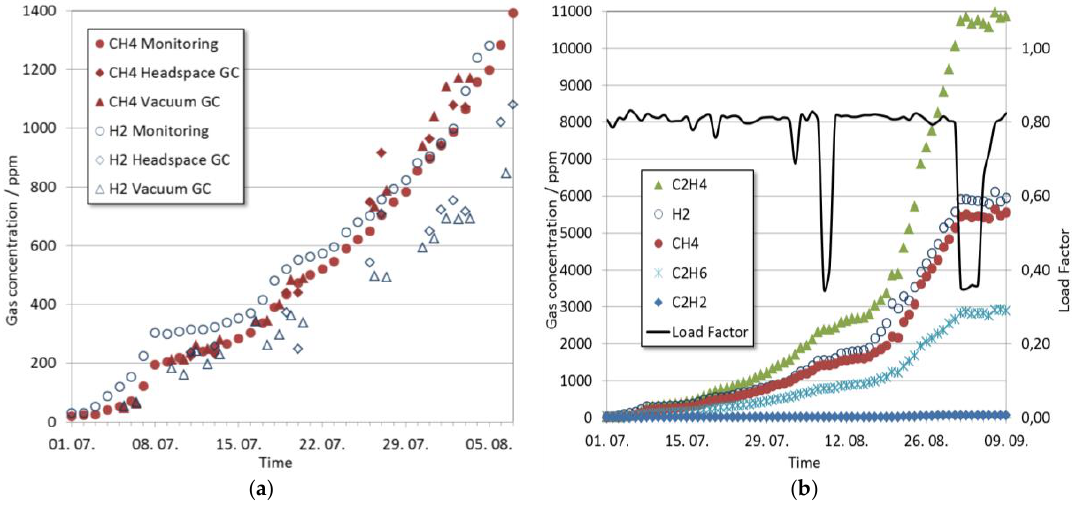
Figure 18. Development of gas concentration of a 600 MVA/380 kV GSU transformer: ( a ) first 5 weeks; and ( b ) 10 weeks